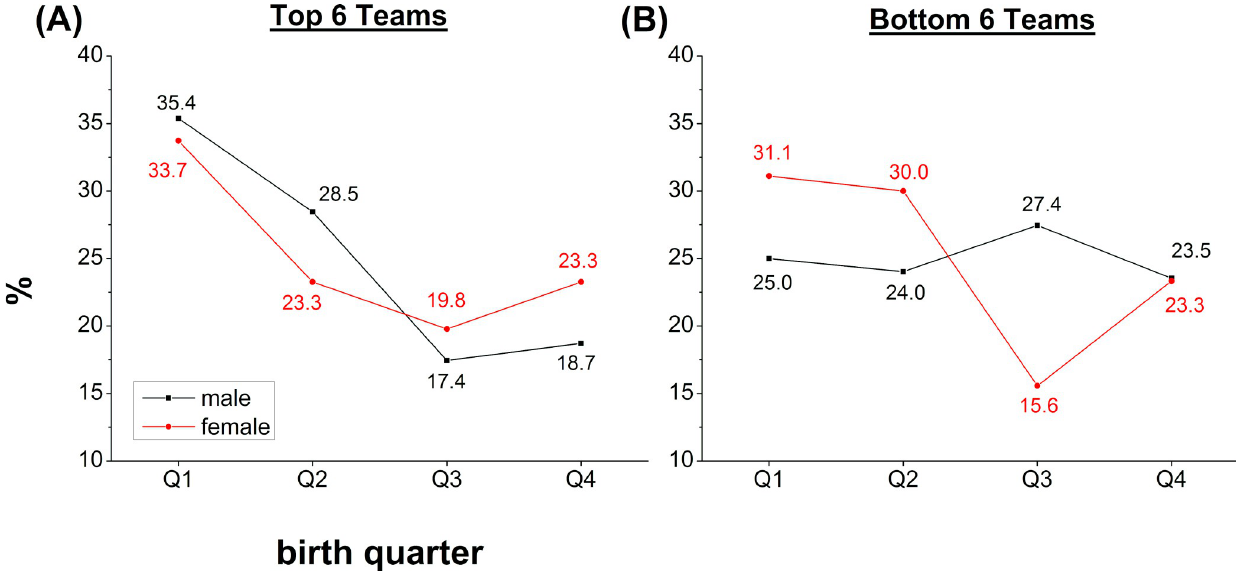
Fig 2. Male and female player distribution for top and bottom teams. Distribution of football male (black) and female (red) players across birth quarters in the top (A) and bottom (B) teams of the Luxemburgish football leagues. Data points reflect average values across age groups.